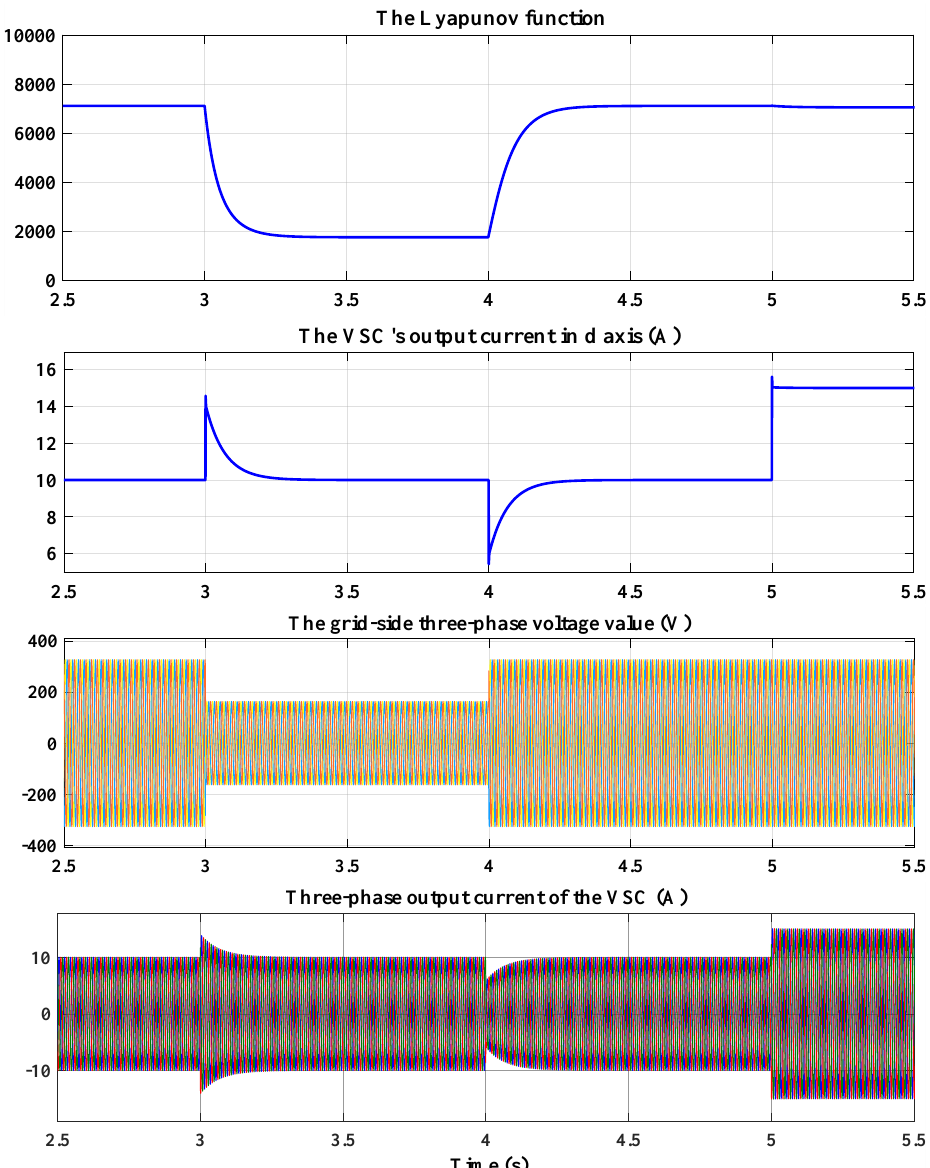
Figure 12. The Lyapunov function,the VSC’s output current in d-axis and in three-phase, and the grid-side three-phase voltage value for voltage sag at t = 3 s for a period of 1 s and a step change in the current reference from 10 A to 15 A at t = 5